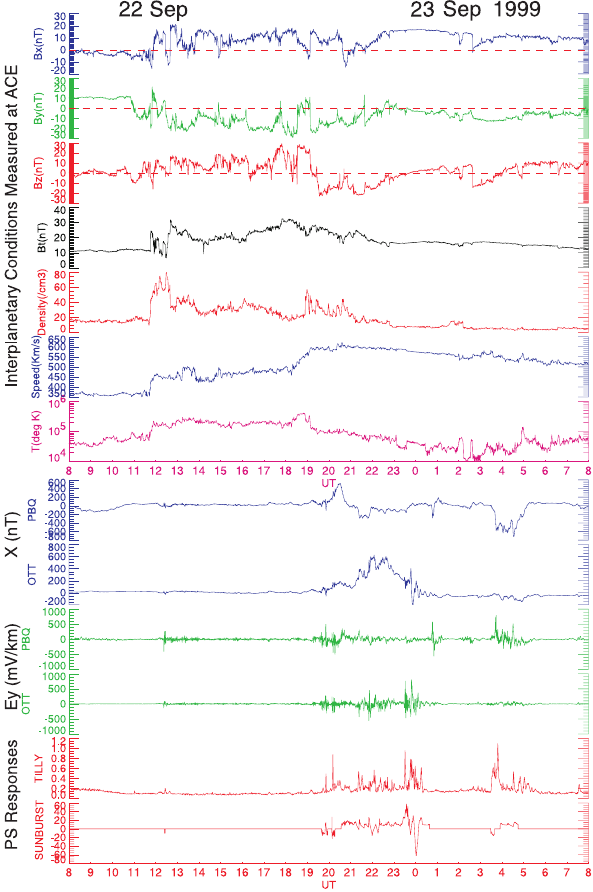
Fig. 7. Same as Fig. 4 except for the 22–23 September